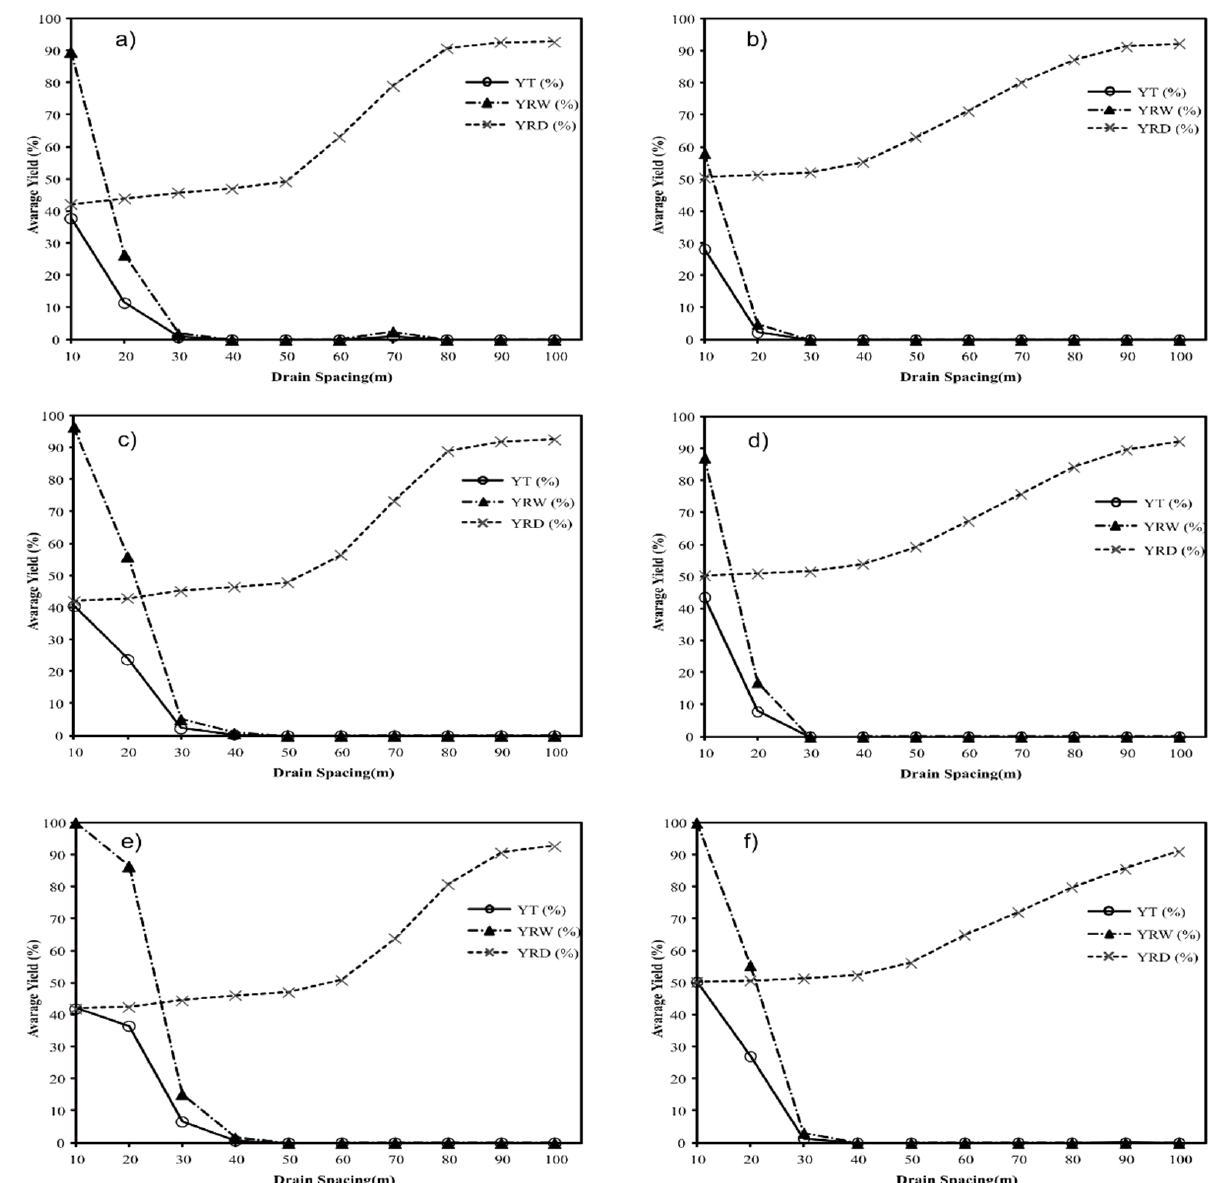
Figure 9. Yield due to excess water (YRW), deficit (YRD) and total (YT) for sugarcane in the period of 1972–2012 for soil 3 for drain spaces varying from 10 to 100 m and drain depths of 1.2 ( a , b ), 1.4 ( c , d ) and 1.6 ( e , f ) m in the Barinas ( a , c , e ) and Turen ( b , d , f ) weather stations. For soil 3, in all rainfall year conditions (Figure 10), the results were similar to the ones obtained previously with approximately 10 m spaces between the drains. We can notice that for this soil, the effect of low hydraulic conductivity is more important than the changes in the rainfall